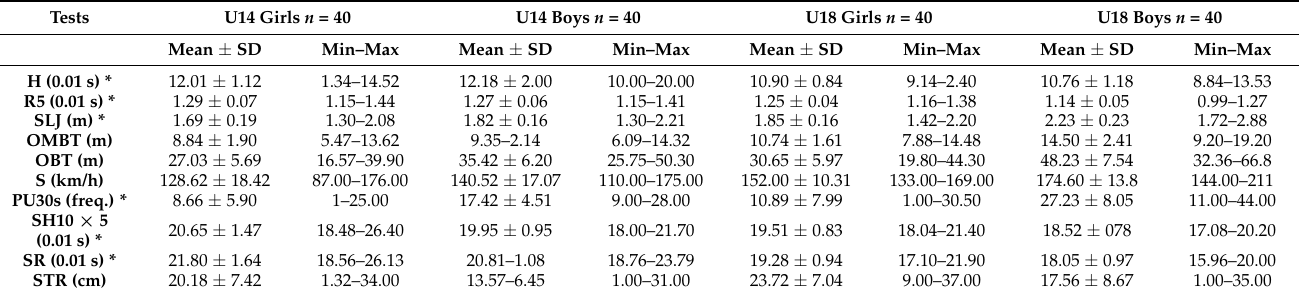
Table 2. The descriptive statistics of the elite junior male and female tennis players ( n = 160).